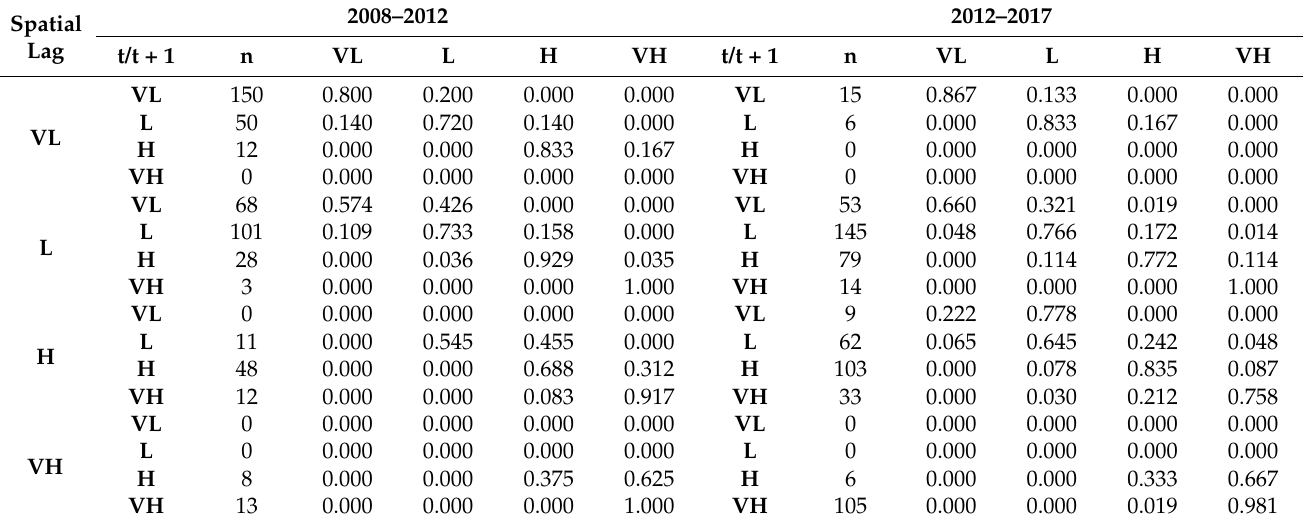
Table 4. Spatial Markov transfer probability matrix by stage for YREB.